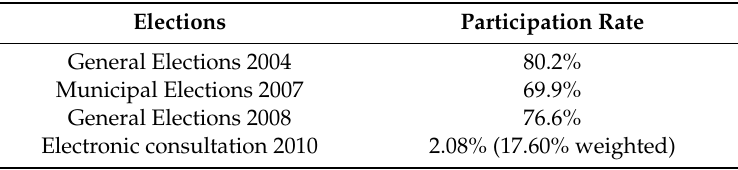
Table 6. Participation in electoral processes in